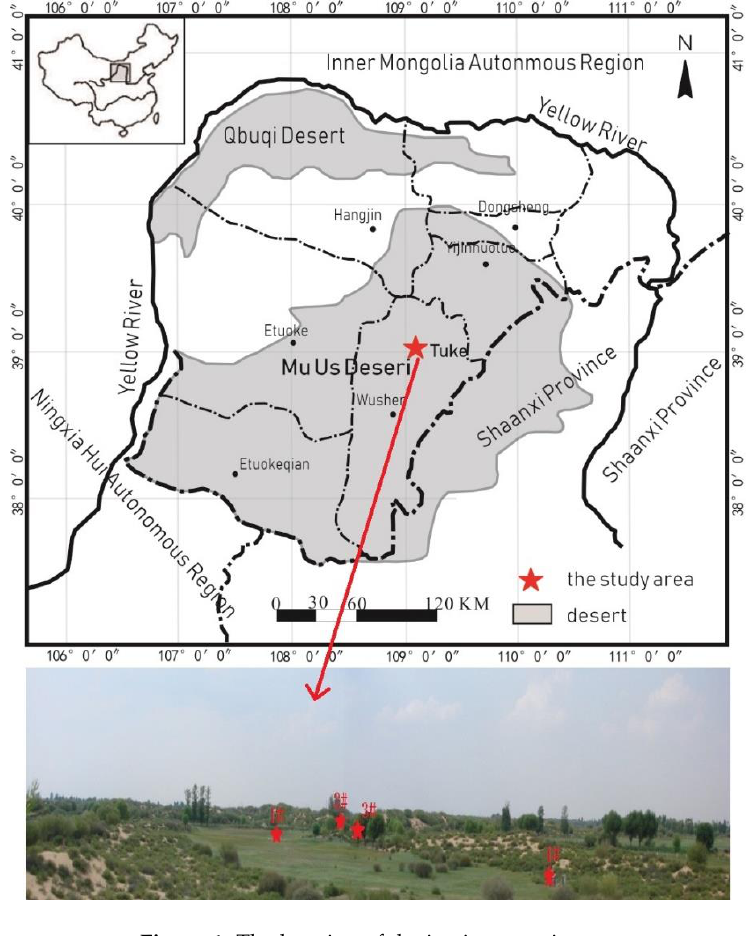
Figure 1. The location of the in-situ experiment.